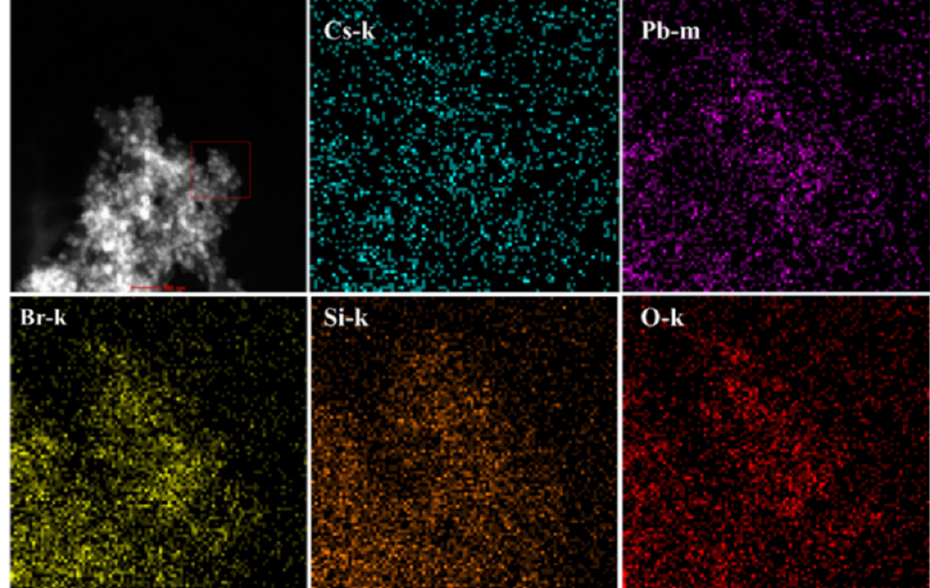
Figure 4. Elemental mapping of Cs, Pb, Br, Si and O of CsPbBr 3 @SiO 2 PNCCs by TEM.